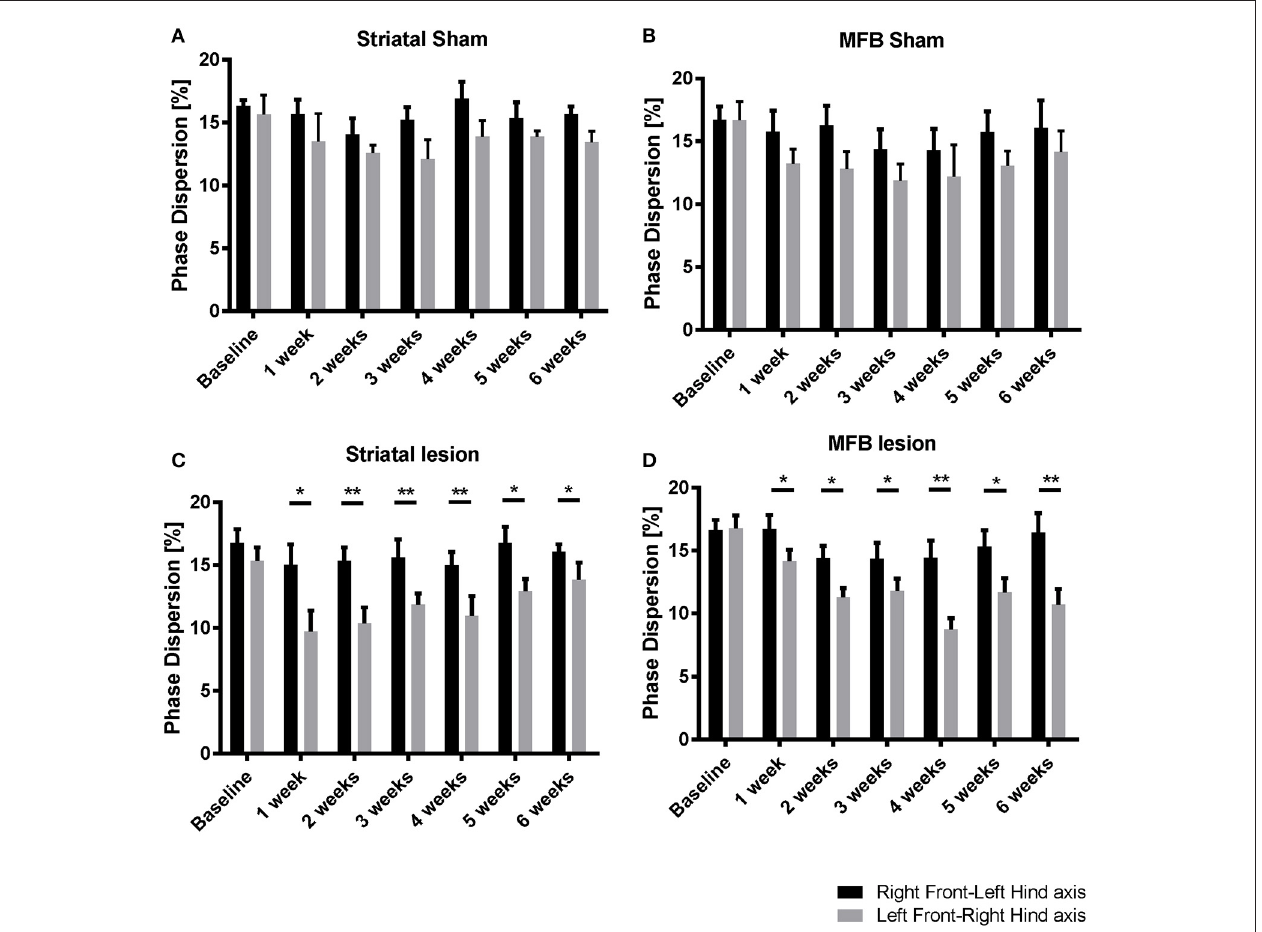
FIGURE 6 | Diagonal phase dispersion alterations following MFB or striatal 6-OHDA lesions. (A) Striatal sham cohort, (B) MFB sham cohort, (C) Striatal lesion group, and (D) MFB lesion group. Data shown as mean ± s.e.m. * P ≤ 0.05; ** P < 0.01 (paired-sample Student t -test).